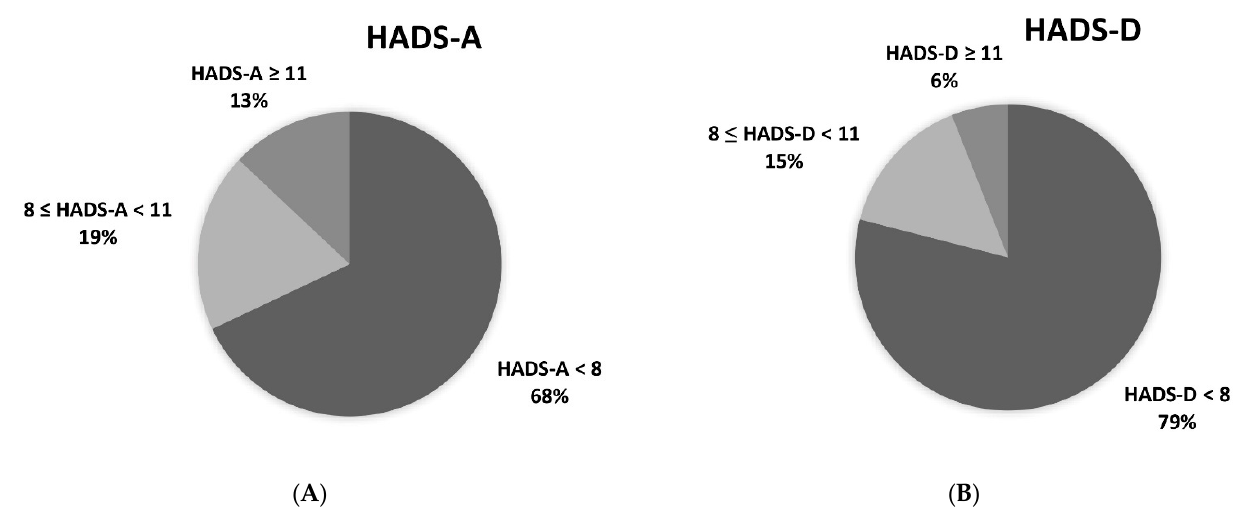
Figure 2. Hospital anxiety and depression scale results (HADS) in PAH and CTEPH patients; ( A ) HADS-A (anxiety subscale): HADS-A < 8 normal value, HADS-A ≥ 8 < 11 moderate anxiety (anxiety suspected), HADSA ≥ 11 severe anxiety (anxiety probable); ( B ) HADS-D (depression subscale): HADS-D < 8 normal value, HADS-D ≥ 8 < 11 moderate depression (depression suspected), HADSA ≥ 11 severe depression (depression probable).